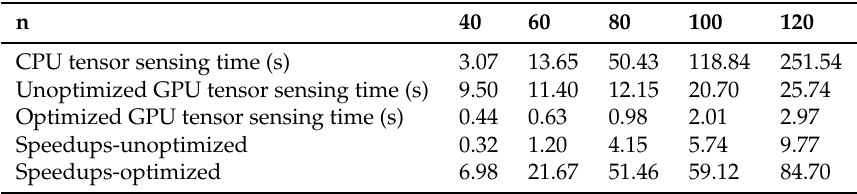
Figure 5. ( a ) The running time of the CPU tensor sensing and GPU tensor sensing and ( b ) the speedups of the unoptimized and optimized GPU tensor sensing. Table 2. Running time under varying tensor sizes ( n × n ×